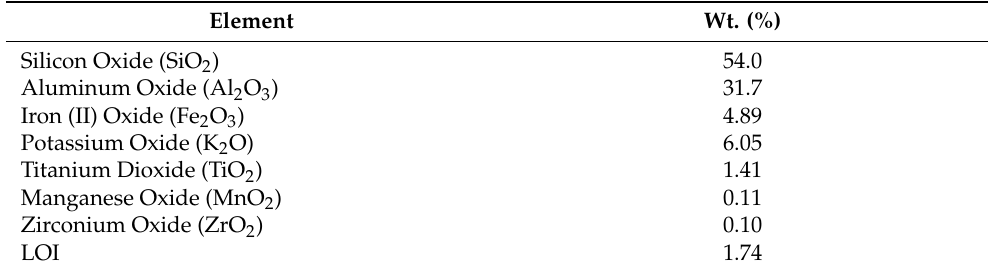
Table 1. Chemical composition of kaolin (wt.%) obtained by X-Ray fluorescence. Element Wt. (%) Silicon Oxide (SiO 2 ) 54.0 Aluminum Oxide (Al 2 O 3 ) 31.7 Iron (II) Oxide (Fe 2 O 3 ) 4.89 Potassium Oxide (K 2 O) Titanium Dioxide (TiO 2 ) 1.41 Manganese Oxide (MnO 2 ) LOI